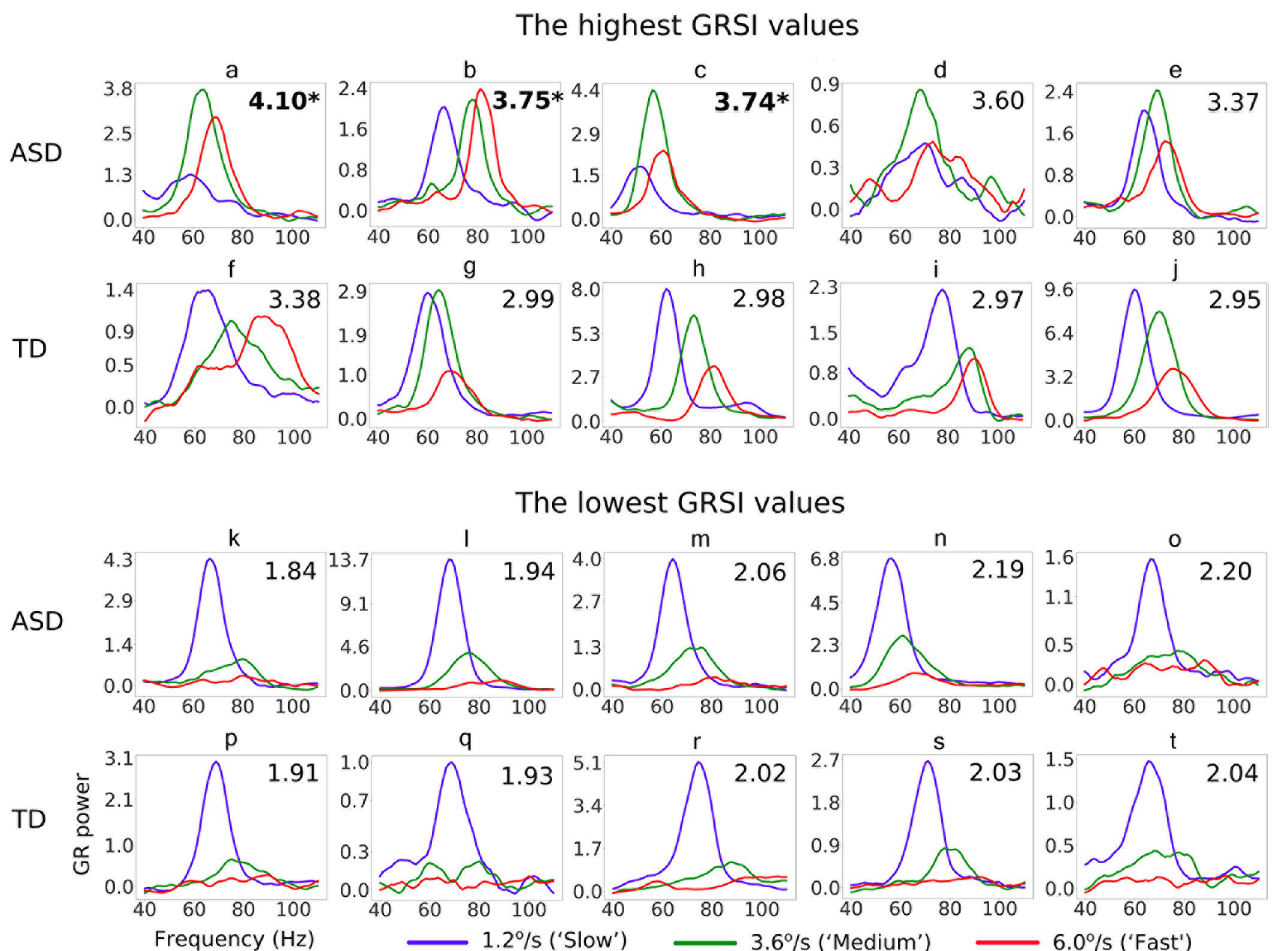
Fig 6. Velocity-related modulation of gamma response (GR) spectrum in TD and ASD children with the five highest (upper panels a-j) and five lowest (lower panels k-t) GRSI values. The GRSI values are shown in each individual’s plot (top right corner); the GRSI values in the outliers’ range are highlighted in bold. Relatively higher GRSI values indicate a weaker suppression of GR by increasing motion